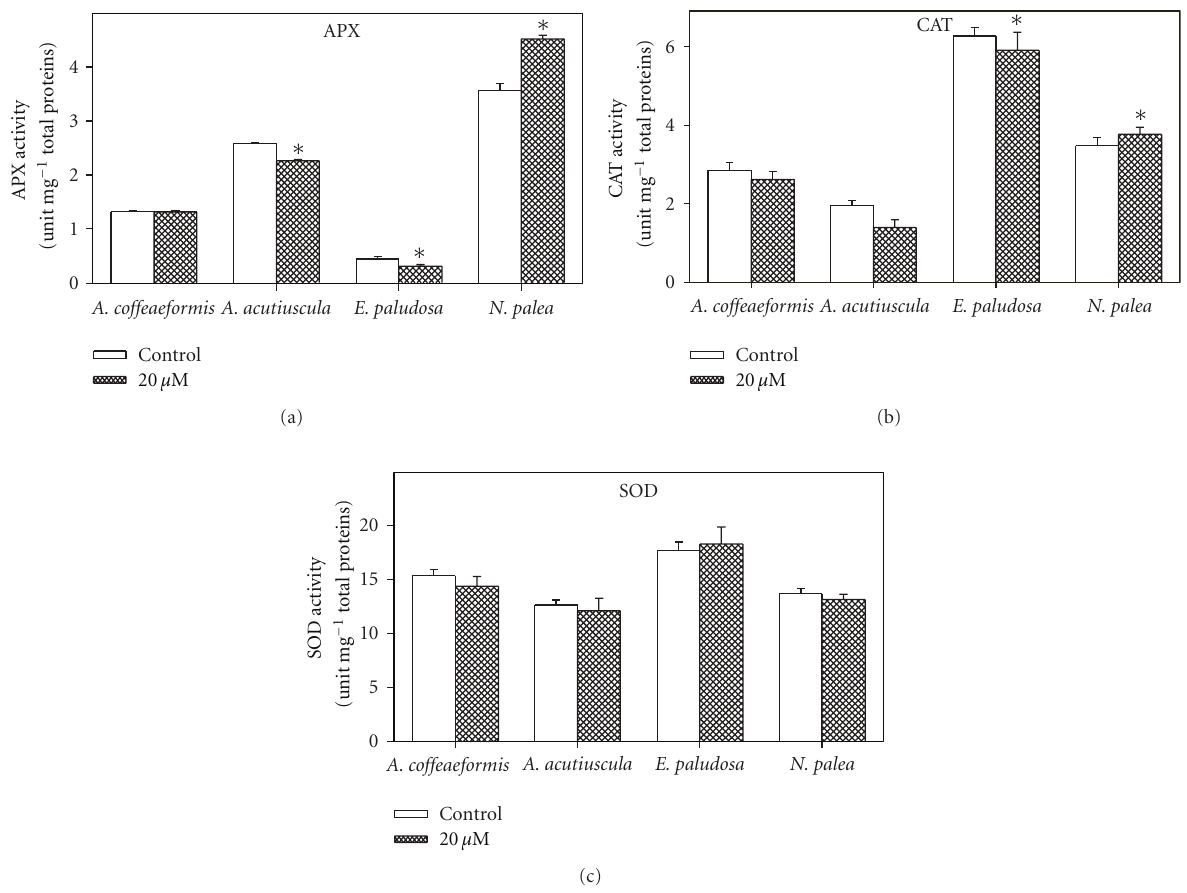
Figure 6: Antioxidant enzymes activities (superoxide dismutase, SOD; catalase, CAT and ascorbate peroxidase, APX) in Amphora co ff eae- formis, Amphora acutiuscula, Entomoneis paludosa, and Nitzschia palea grown in ASW (control) or in the presence of 20 μ M Zn added to ASW. Significant di ff erences are indicated by an asterisk ( P ≤ 0 . 05). Mean values ± SE ( n = 3–5).